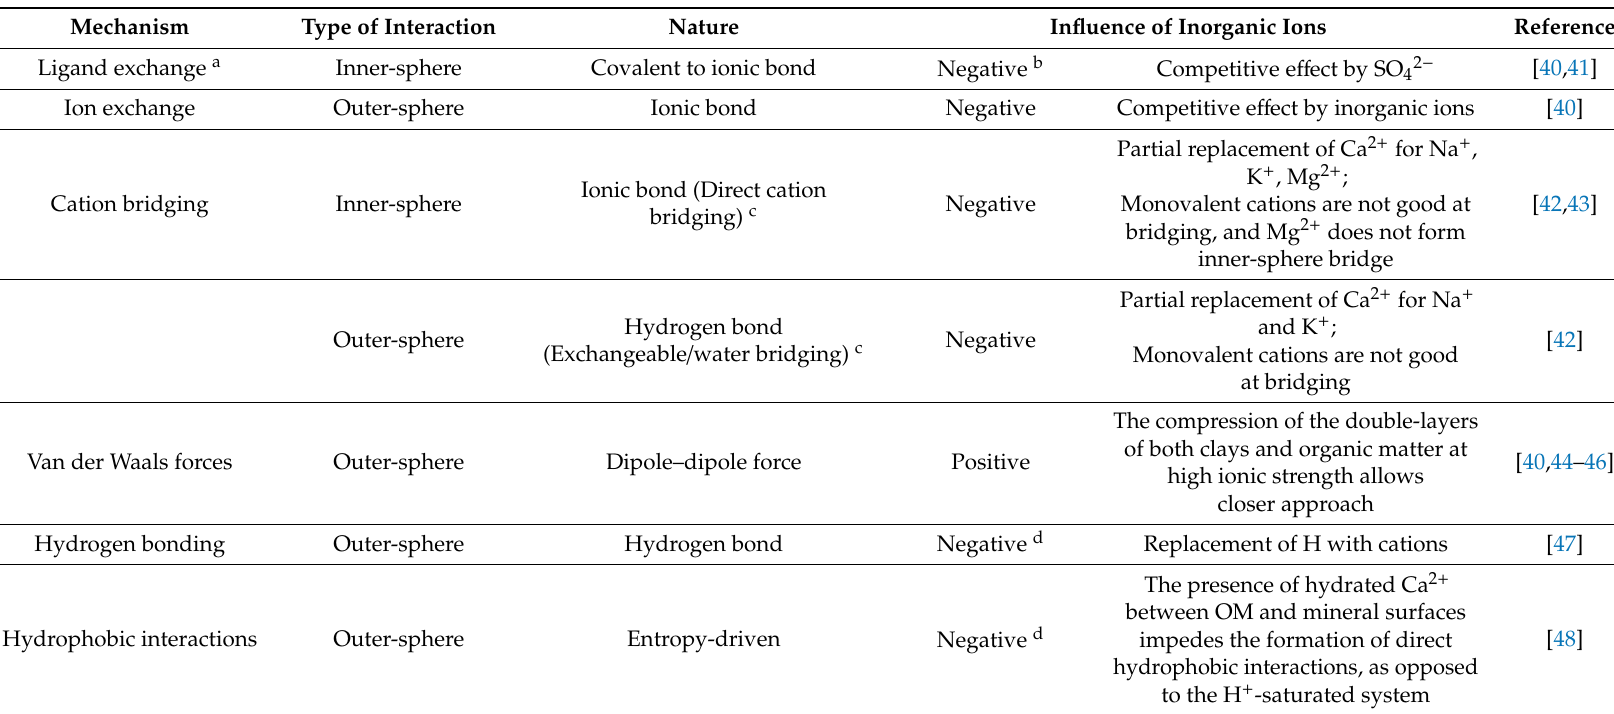
Table 1. Mechanisms behind organic matter interactions with mineral surfaces and influence of seawater inorganic